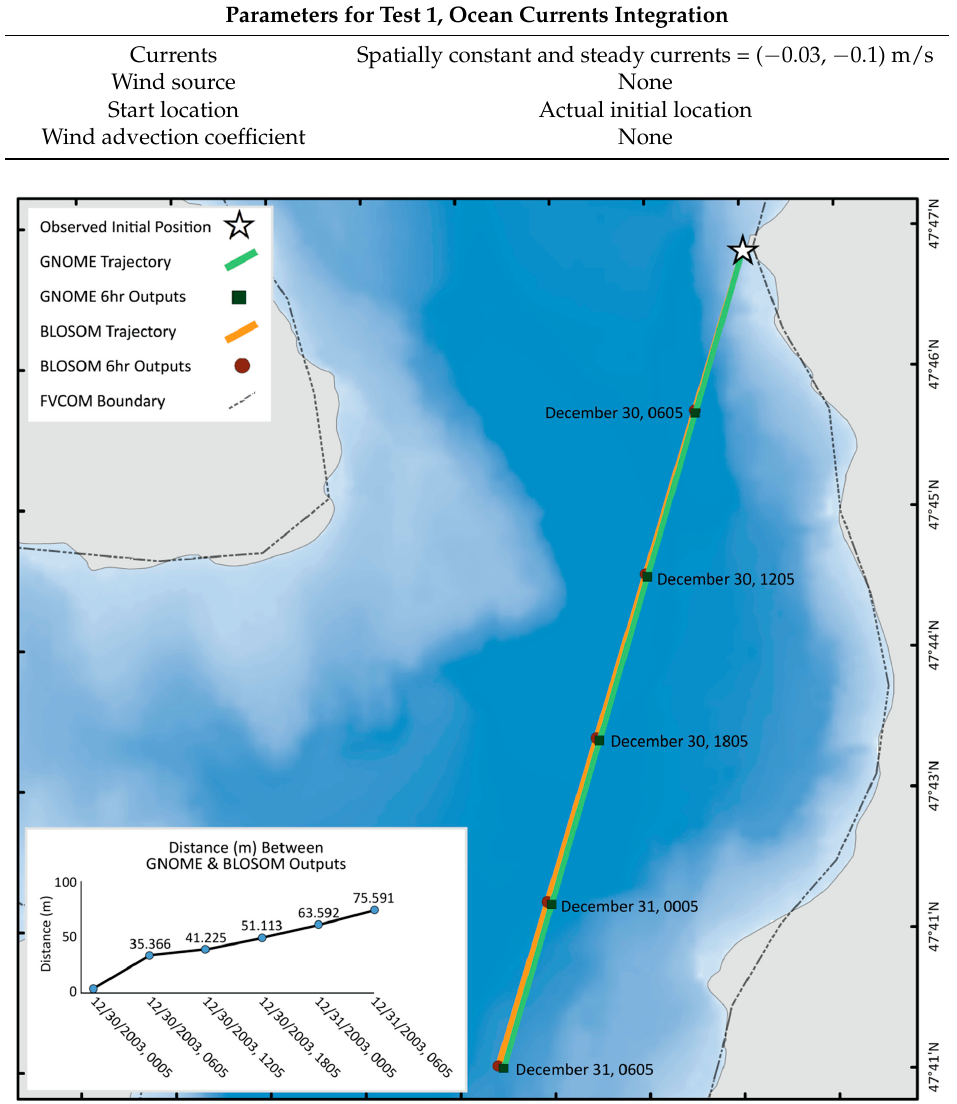
Table 3. Parameters for test 1, ocean currents integration.